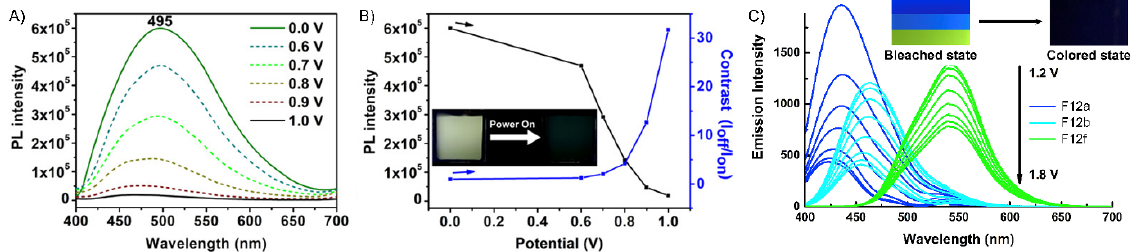
Figure 9. Electrofluorochromism of F6 in solution ( A ) and in a full device ( B ). Electrofluorochromism of F12a , b , and f in a full-device configuration ( C ) [93,98]. ( A , B ) Reproduced with permission from ref. [98]. Copyright 2019 American Chemical Society. ( C ) Reproduced with permission from ref. [93]. Copyright 2020 Elsevier.